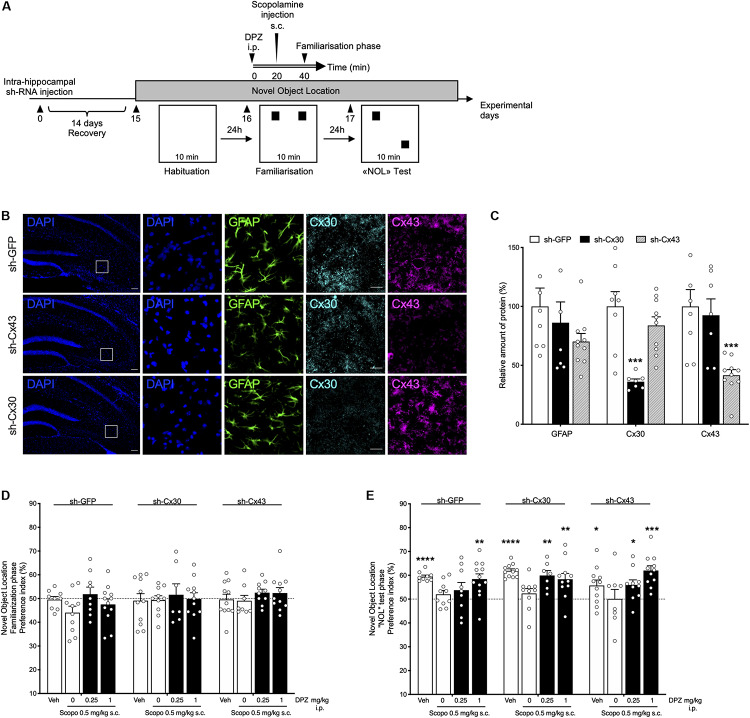
Behavioral effects of donepezil (DPZ) on scopolamine (Scopo)–induced deficits in mice with down-regulated hippocampal shCx43 or shCx30. (A) Experimental design: novel object location task. Recombinant lentiviruses aimed at locally down-regulating either Cx30 (sh-Cx30) or Cx43 (sh-Cx43) expression or that of GFP (sh-GFP, as control) specifically in astrocytes were administered into the hippocampus, on both sides. Two weeks later, DPZ (0.25, 1 mg/kg, i.p.) or vehicle (veh, DMSO 2%, NaCl 0.9%, i.p.) was administered 40 min before the familiarization phase (day 16) of the task. Scopolamine (0.5 mg/kg, s.c.) was administered 20 min later, that is, 20 min before the familiarization phase. [(B), from left to right] Representative fluorescence microscopy images of hippocampal nuclei (DAPI, blue), GAFP (green), Cx30 (light blue), and Cx43 (purple) labeling (square boxes on DAPI-labeled sections correspond to the four series of images on the right). Scale bar: 100 μm. (C) Relative hippocampal expression of GFAP, Cx43, or Cx30 in sh- GFP-, sh-Cx43- and sh-Cx30-injected mice. Data are expressed as mean ± SEM, n = 7 to 10 mice per group. Two-way ANOVA followed by Tukey post hoc test, ∗∗∗P < 0.001, significantly different from the corresponding group injected with sh-GFP. (D,E) Preference index for the similar objects (D) and the displaced object (E). One-sample t-test: ∗P < 0.05;**P < 0.01; ∗∗∗P < 0.001; ****P < 0.0001 vs chance level. Data are expressed as mean ± SEM, n = 7 to 12 mice per group.